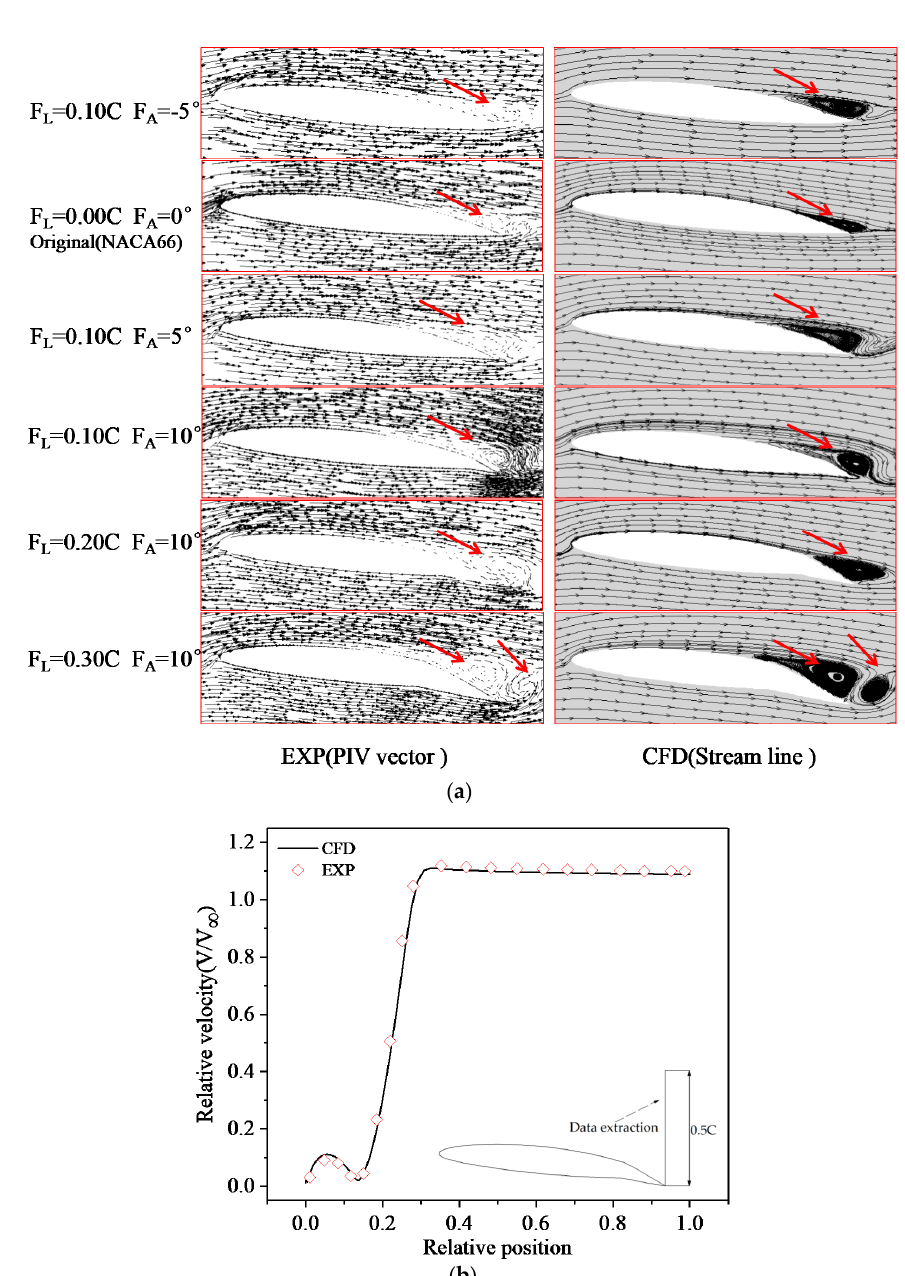
Figure 5. Reliability verification (AOA = 6; Re = 3.75 × 10 5 ): ( a ) velocity vector diagram; ( b ) relative velocity.